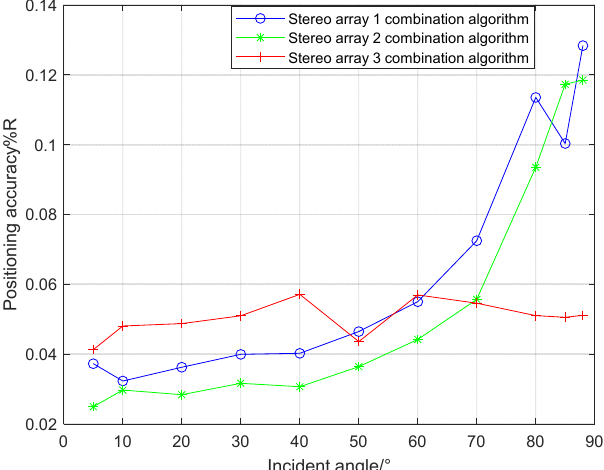
Figure 22. Comparison of three stereo arrays under combination algorithm. Table 1. The localization processing